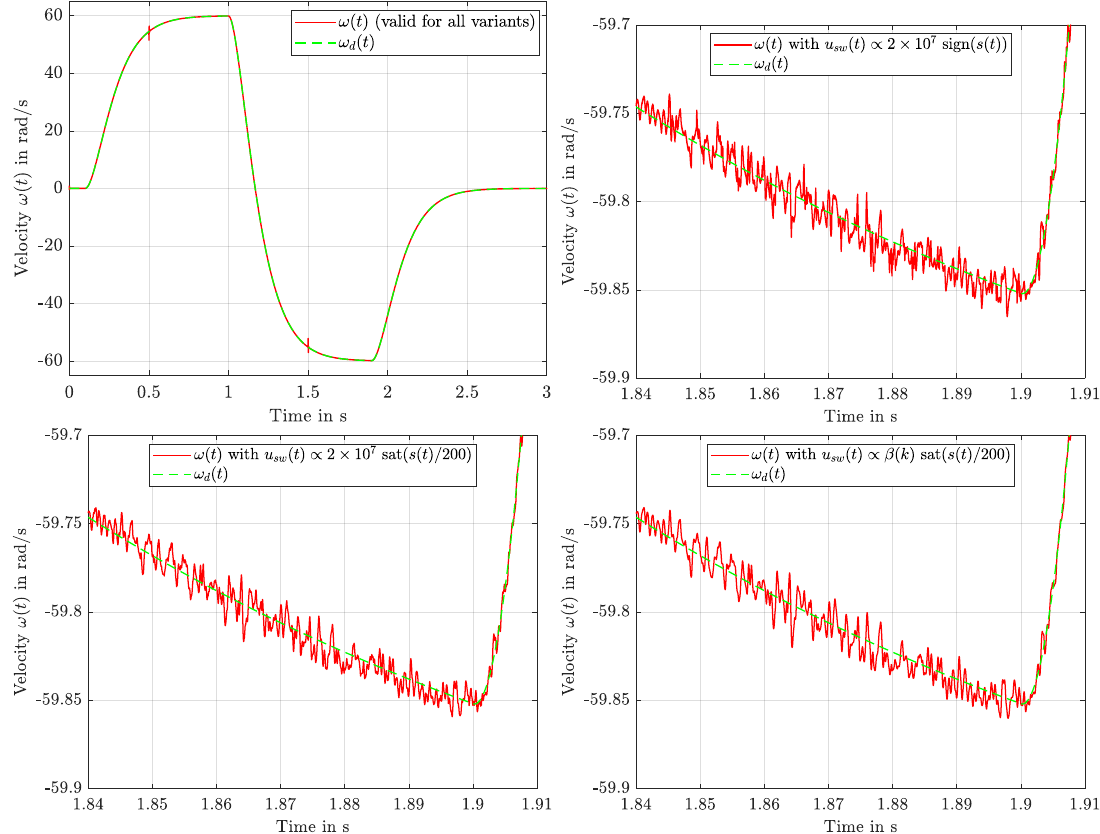
Figure 5. Tracking behaviour of the angular velocity ω : comparison of desired and simulated values for all variants ( top , left ); detailed views at point with the lowest angular velocity ( top , right ; bottom ).